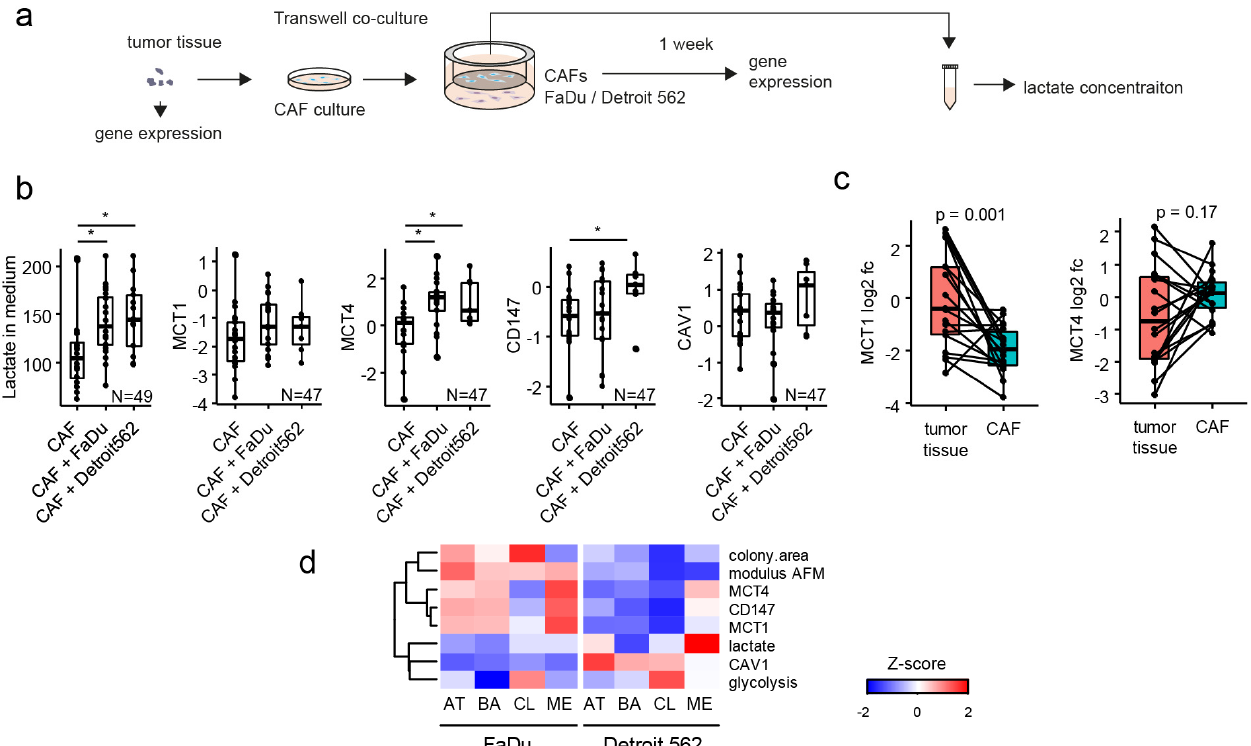
Figure 4. Coculture of the CAFs with cancer cell lines increases lactate in medium and lactate shuttle-relevant gene expression in CAFs. ( a ) scheme of measurement, ( b ) levels of lactate in medium and lactate-shuttle-relevant genes expression level in CAFs, asterisk indicate p < 0.05 in paired t -test. ( c ) MCT1 and MCT4 gene expression in tumour tissue and corresponding tumour tissue-derived CAFs. p indicates the result of paired t -test, individual dots represent individual patient-derived CAFs. ( d ) summary of the coculture data –shown as an integrative heatmap of measured data on cocultured cells, shown as a mean-per-mRNA subtype (CL, classical, AT, atypical, BA, basal, ME, mesenchymal).